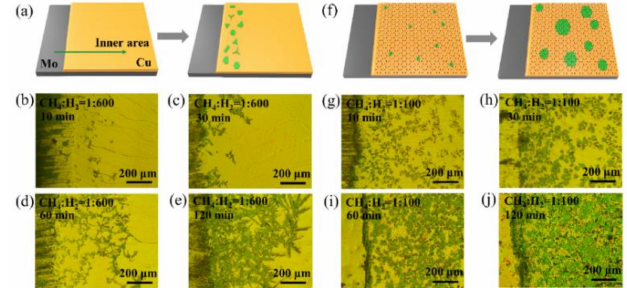
Figure 3. The schematic diagram and optical image showing the growth of Mo 2 C and Mo 2 C—Gr under various ratios of methane to hydrogen and various growth times. ( a ) The schematic diagram of the distribution of Mo 2 C crystals on the Cu/Mo substrate at the ratio of 1:600. ( b – e ) The distribution of Mo 2 C crystals on the Cu/Mo substrate with a growth time of 10, 30, 60 and 120 min, respectively. ( f ) The schematic diagram of the distribution of the grown Mo 2 C—Gr on the Cu/Mo substrate at the ratio of 1:100. ( g – j ) The growth of Mo 2 C—Gr and distribution of Mo 2 C crystals on the Cu/Mo substrate with a growth time of 10, 30, 60 and 120 min, respectively.